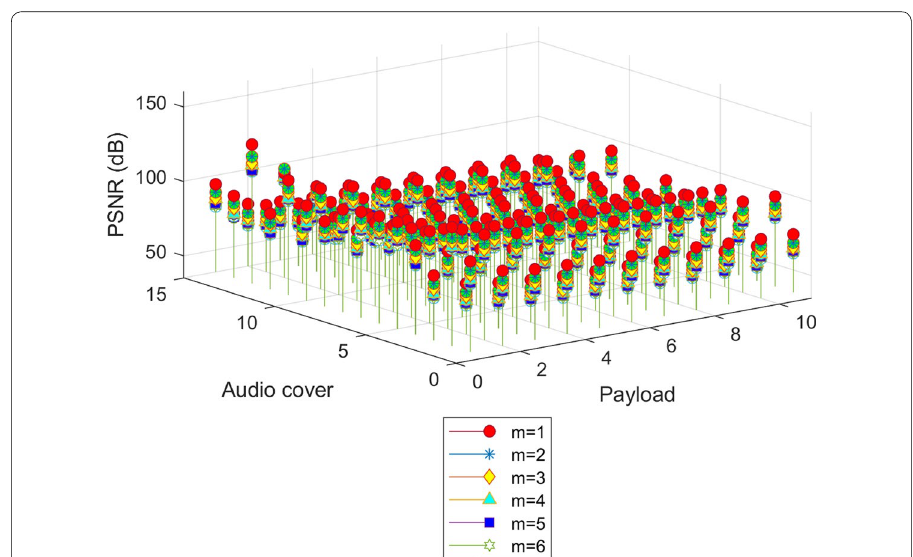
Fig. 5 The effect of multiplier ( m ) on the quality of the stego files, where m ∈ { 1,2,3,4,5,6 } , e = 3 and h = 1